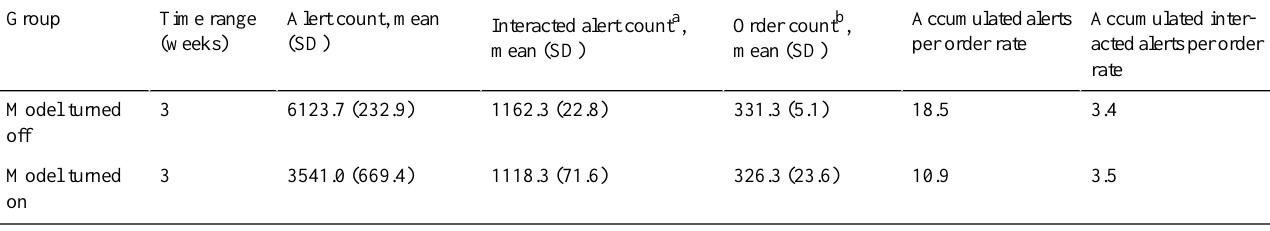
Table 2. Shingles alert–related volume in 2019. Each statistic is the weekly average of the corresponding group during the 6-week biweekly cycle except that alerts per order rates were calculated as bulk averages within each 3-week group,